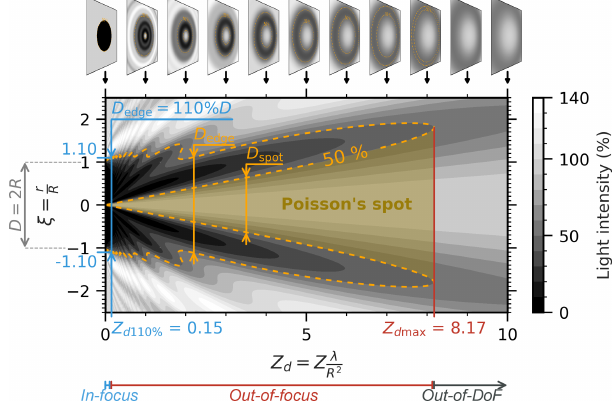
Figure 2. Intensity level of the diffraction pattern of an opaque disc in Z d – ξ coordinates: the intensity profile along the ξ axis at a spe- cific Z d represents the intensity profile along a section of the diffrac- tion pattern of an opaque disc at a distance Z d (see the diffraction pattern for Z d = 1 . 0 in Fig. 1). As Z d increases, the image be- comes less focused and the diameter of the Poisson spot increases. At the 50% intensity triggering level, the external diameter of the diffraction pattern of the disc shadow can appear with magnifica- tion greater than 110% from Z d = 0 . 15, which we define as the arbitrary limit of an in-focus image, and the disc shadow totally dis- appears beyond Z d = 8 .